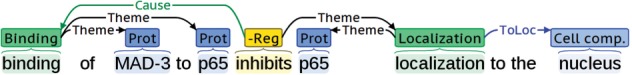
Example sentence with event annotation. Prot, -Reg and Cell comp. abbreviated for Protein, Negative regulation and Cell component, respectively